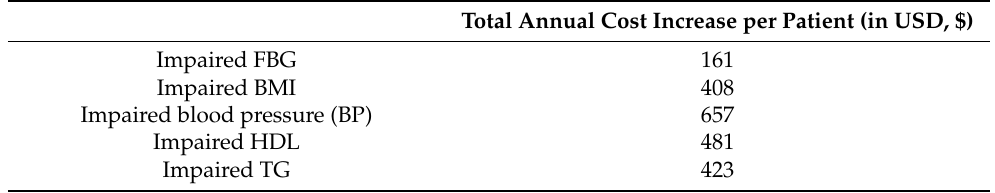
Table 4. Annual medical cost increase per patient with each metabolic syndrome component (table content elaborated and modified form the original work by Nichols et al., 2011